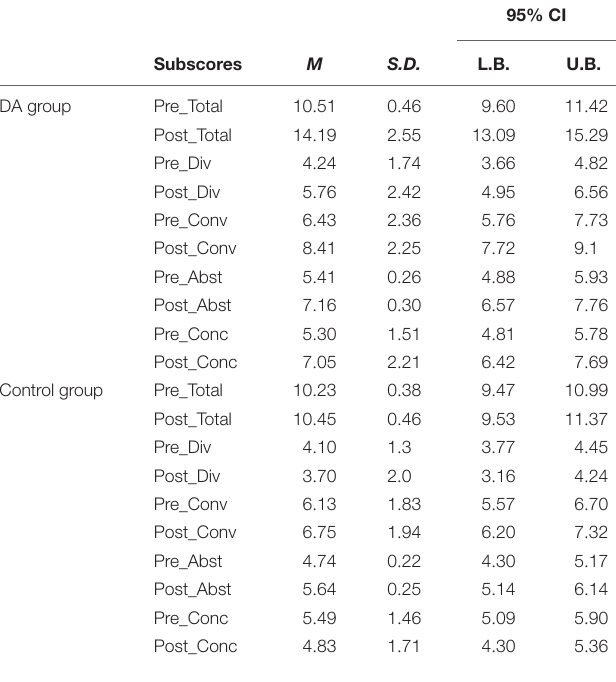
TABLE 2 | Descriptives of pre- and post-test EPoC subscores by group.